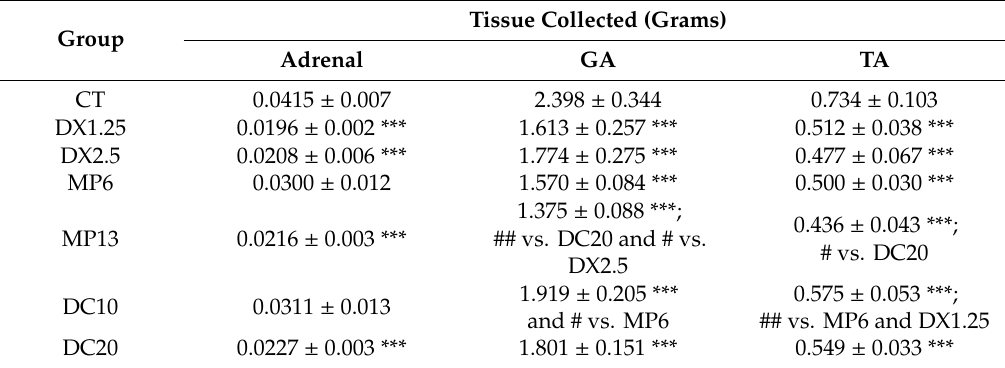
Table 2. Weight of collected adrenal and muscle